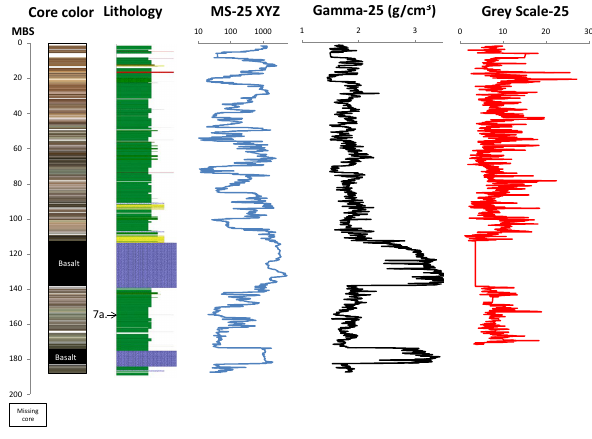
Figure 5. Summary stratigraphy of core HSPDP-NAO14-1B, from the Oso Isi locality, Northern Awash drilling area, northern Ethiopia, based on initial core description results. Columns from left to right: core color stratigraphy (from XYZ spectrophotometric imaging data, adjusted in Photoshop © to using Image Adjustment Levels to maximize color range). Basalt intervals were not imaged and are shown as solid black and missing core intervals are shown in white; lithologic log, rendered in PSICAT © . See Fig. 5 for the key to lithologies used in all cores illustrated. Zones with missing cores are indicated by blank intervals. Letter/number markers and arrows to the left of the lithologic log indicate the position of corre- sponding core photos in Fig. 7 for this and other summary stratig- raphy figures; composite of magnetic susceptibility (MS) log data from the LacCore Geotek © XYZ point sensor data on split core seg- ments, measured at 0.5cm increments. Data have been smoothed (25-point running mean smooth, hence MS-25, Gamma-25, and Grey Scale-25); composite of induced gamma density log data at 0.5cm increments from the LacCore Geotek © Multisensor Core Logger (MSCL). Spurious values (<1.4gmcm − 3 ) caused by cor- ing gaps have been removed prior to analysis and plotting. Data have been smoothed (25-point running mean); composite of spec- trophotometric grey-scale log data at 0.5cm increments from the LacCore Geotek © XYZ spectrophotometric sensor. Data have been smoothed (25-point running